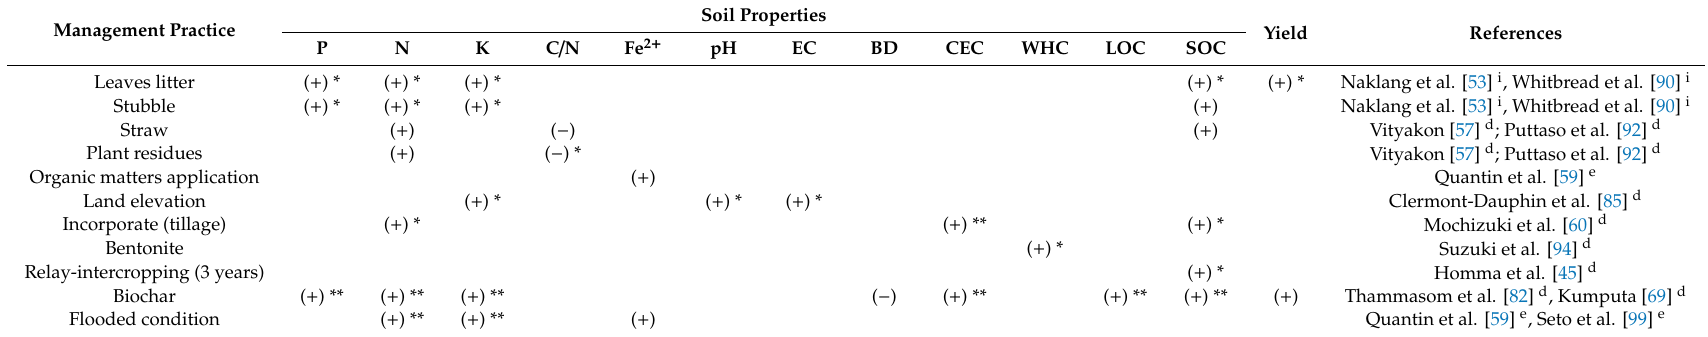
Table 4. Overview on correlation between soil characteristics (within the range of 0–40 cm depth) or rice yield with management practices of rice-based cropping under sandy soil condition of Northeast